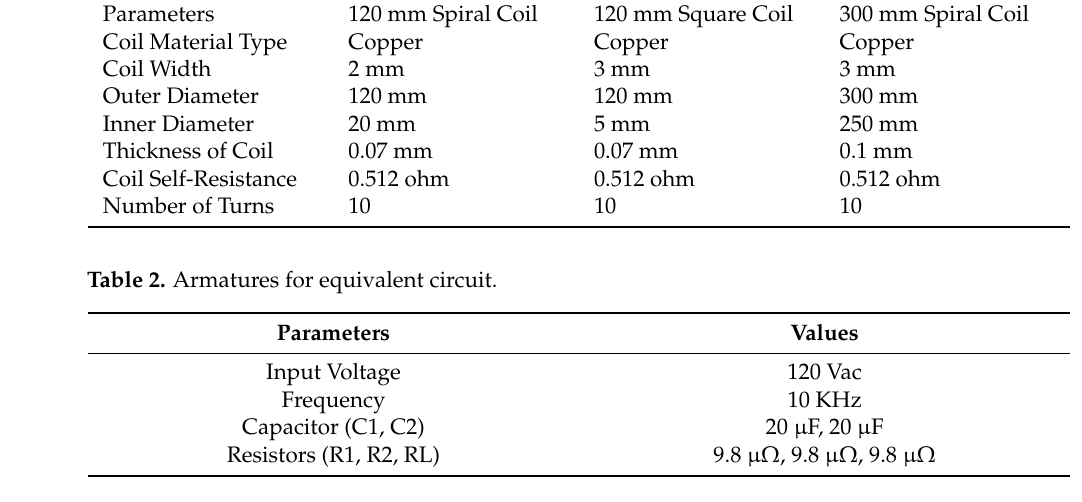
7 Table 1. Armatures of coil design. Value/Type/Unit Parameters